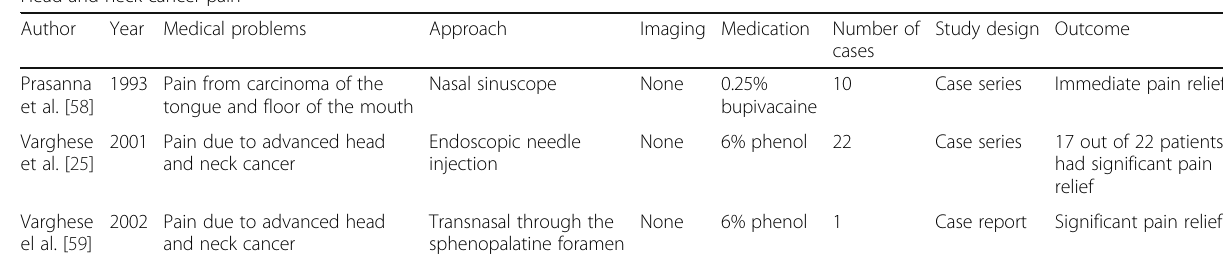
Table 7 Studies of SPG block for cancer pain Head and neck cancer pain